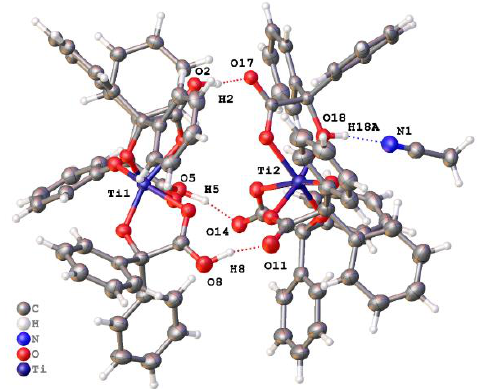
Figure 2. Asymmetric unit of 2 with atoms drawn as 50% probability ellipsoids. Dashed lines show classical hydrogen bonds. Selected bond lengths (Å) and bond angles ( o ): Ti(1)-O(1) 2.0679(18), Ti(1)-